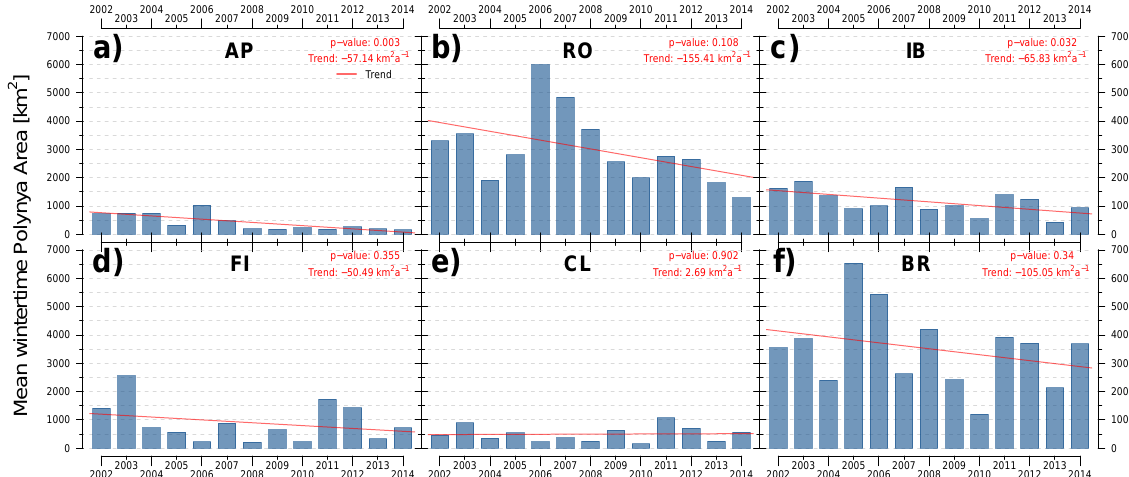
Figure 7. Mean wintertime polynya area (POLA, km 2 ) for the years from 2002 to 2014 during the winter period from April to September. The red line indicates the multi-year regional trend (km 2 a − 1 ). p value and numeric trend are stated in the top right corner for each subregion.